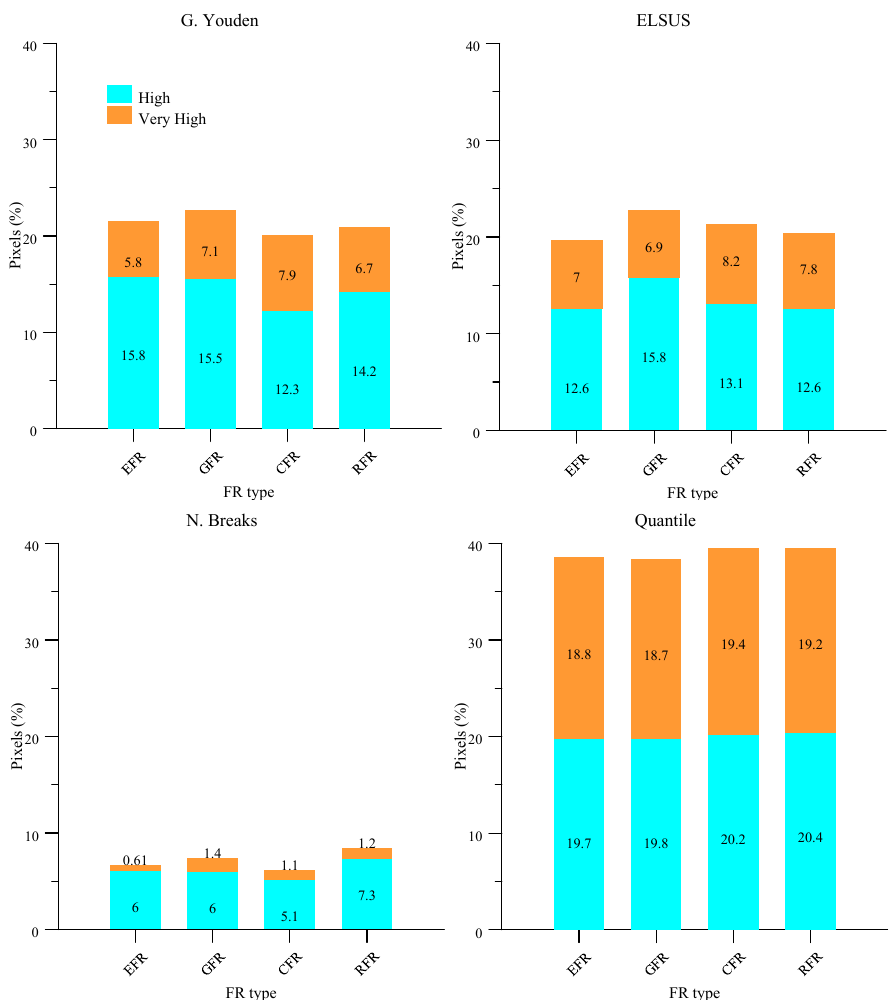
Figure 6. Surface percentage for high susceptibility classes (very high and high) in Valencia Region.